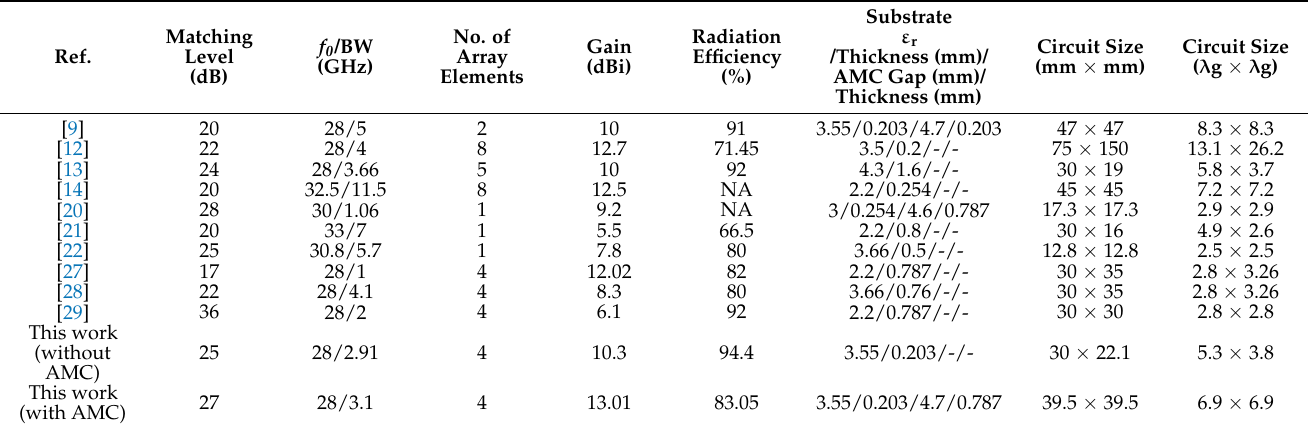
Table 1. Comparison with other reported